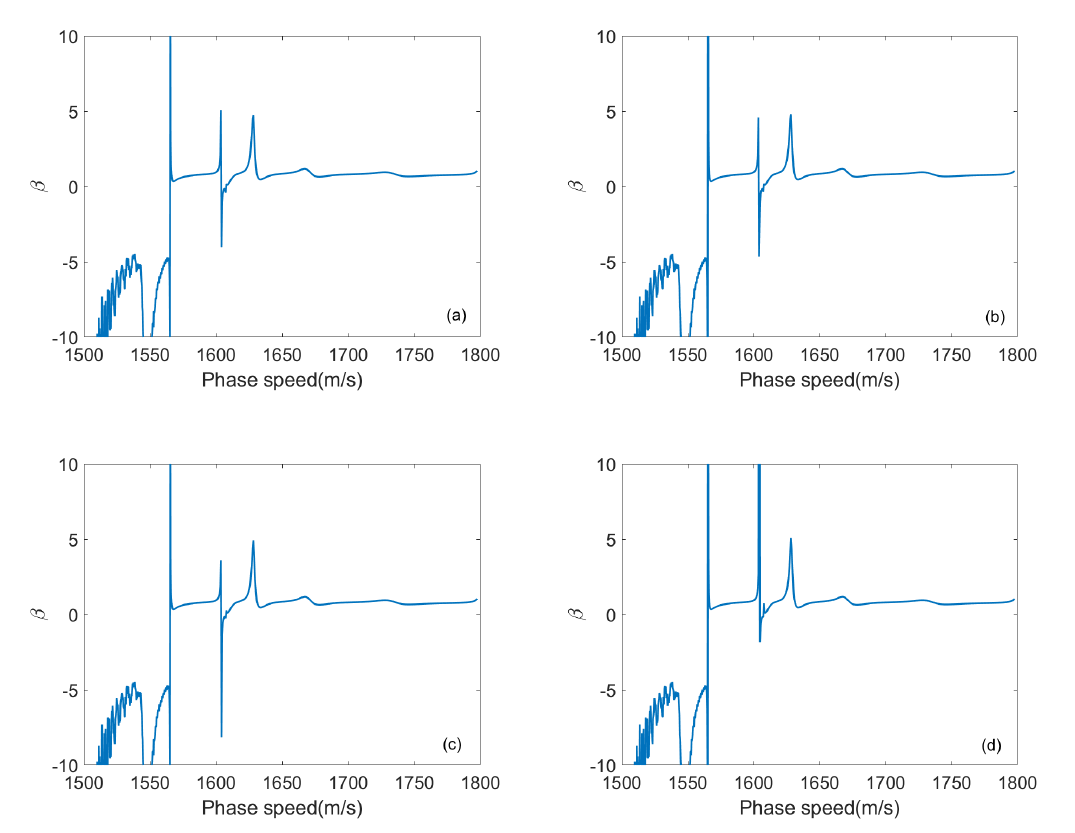
Figure 9. The WI parameter β varies with different attenuation coefficients. ( a ) 0 dB/ λ ; ( b ) 0.2 dB/ λ ; ( c ) 0.4 dB/ λ ; ( d ) 0.6 dB/ λ .